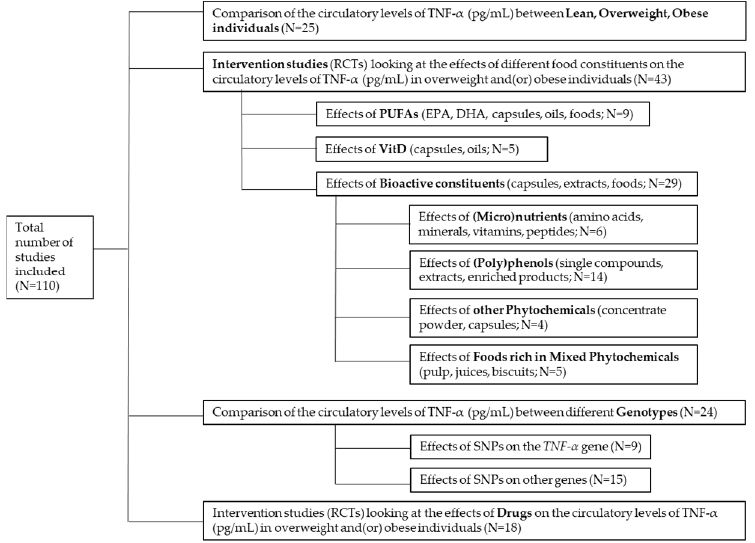
Figure 2. Diagram summarising the studies revised in this Review (N = number of studies included).